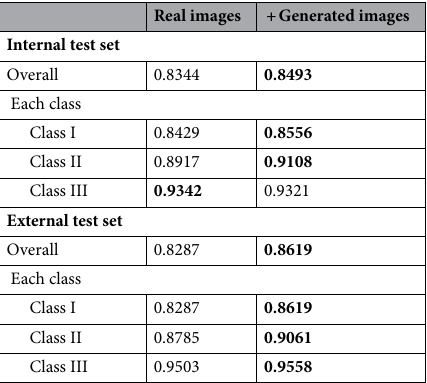
Table 3. Accuracies of the classification model for internal and external test sets. Training using only the real dataset is indicated by Real images and training using the real dataset with generated images is indicated by + Generated images.